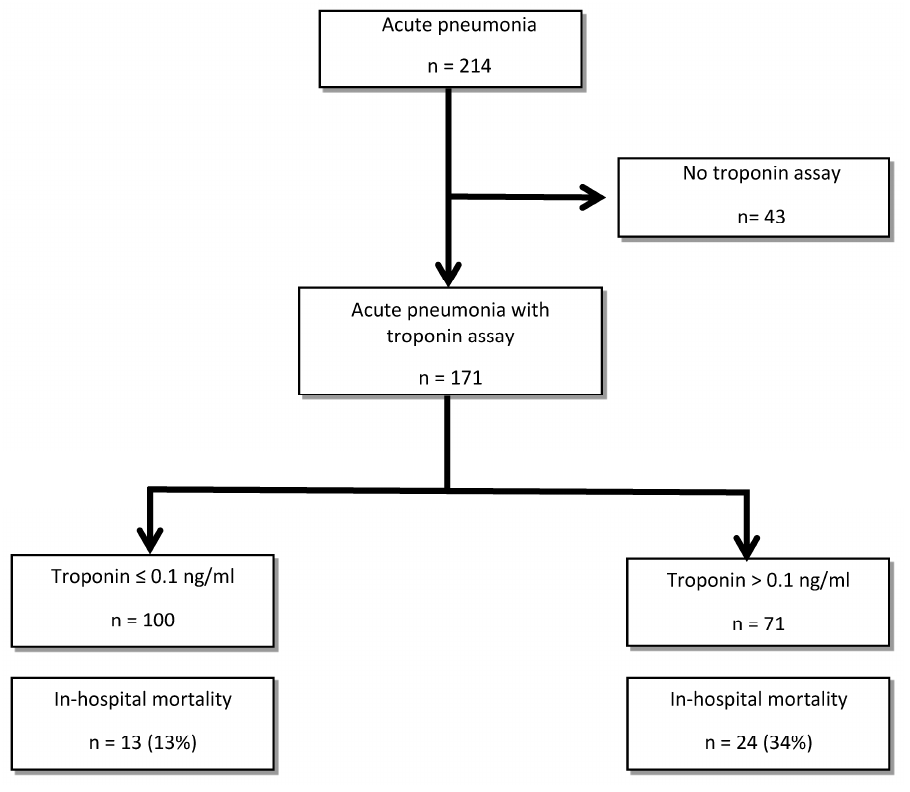
Figure 1. Flow Figure 1. Flow chart.